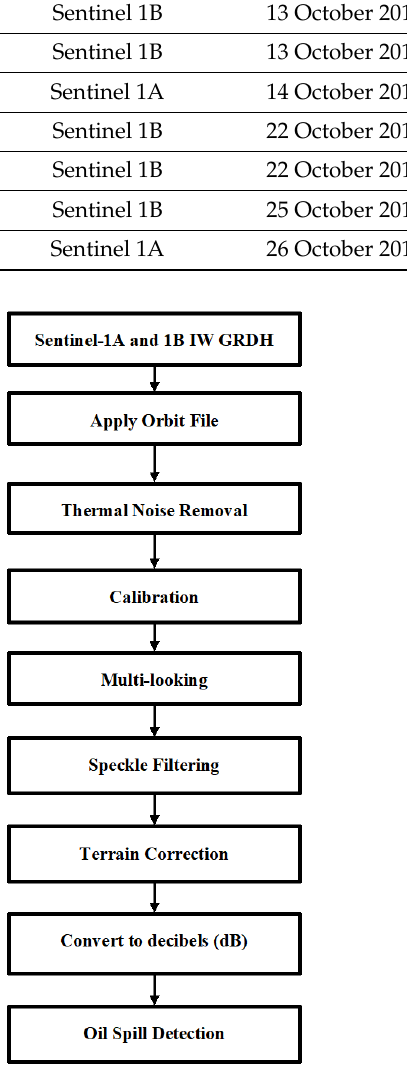
Figure 2. Sentinel ‐ 1 GRD pre ‐ processing workflow. Figure 2. Sentinel-1 GRD pre-processing